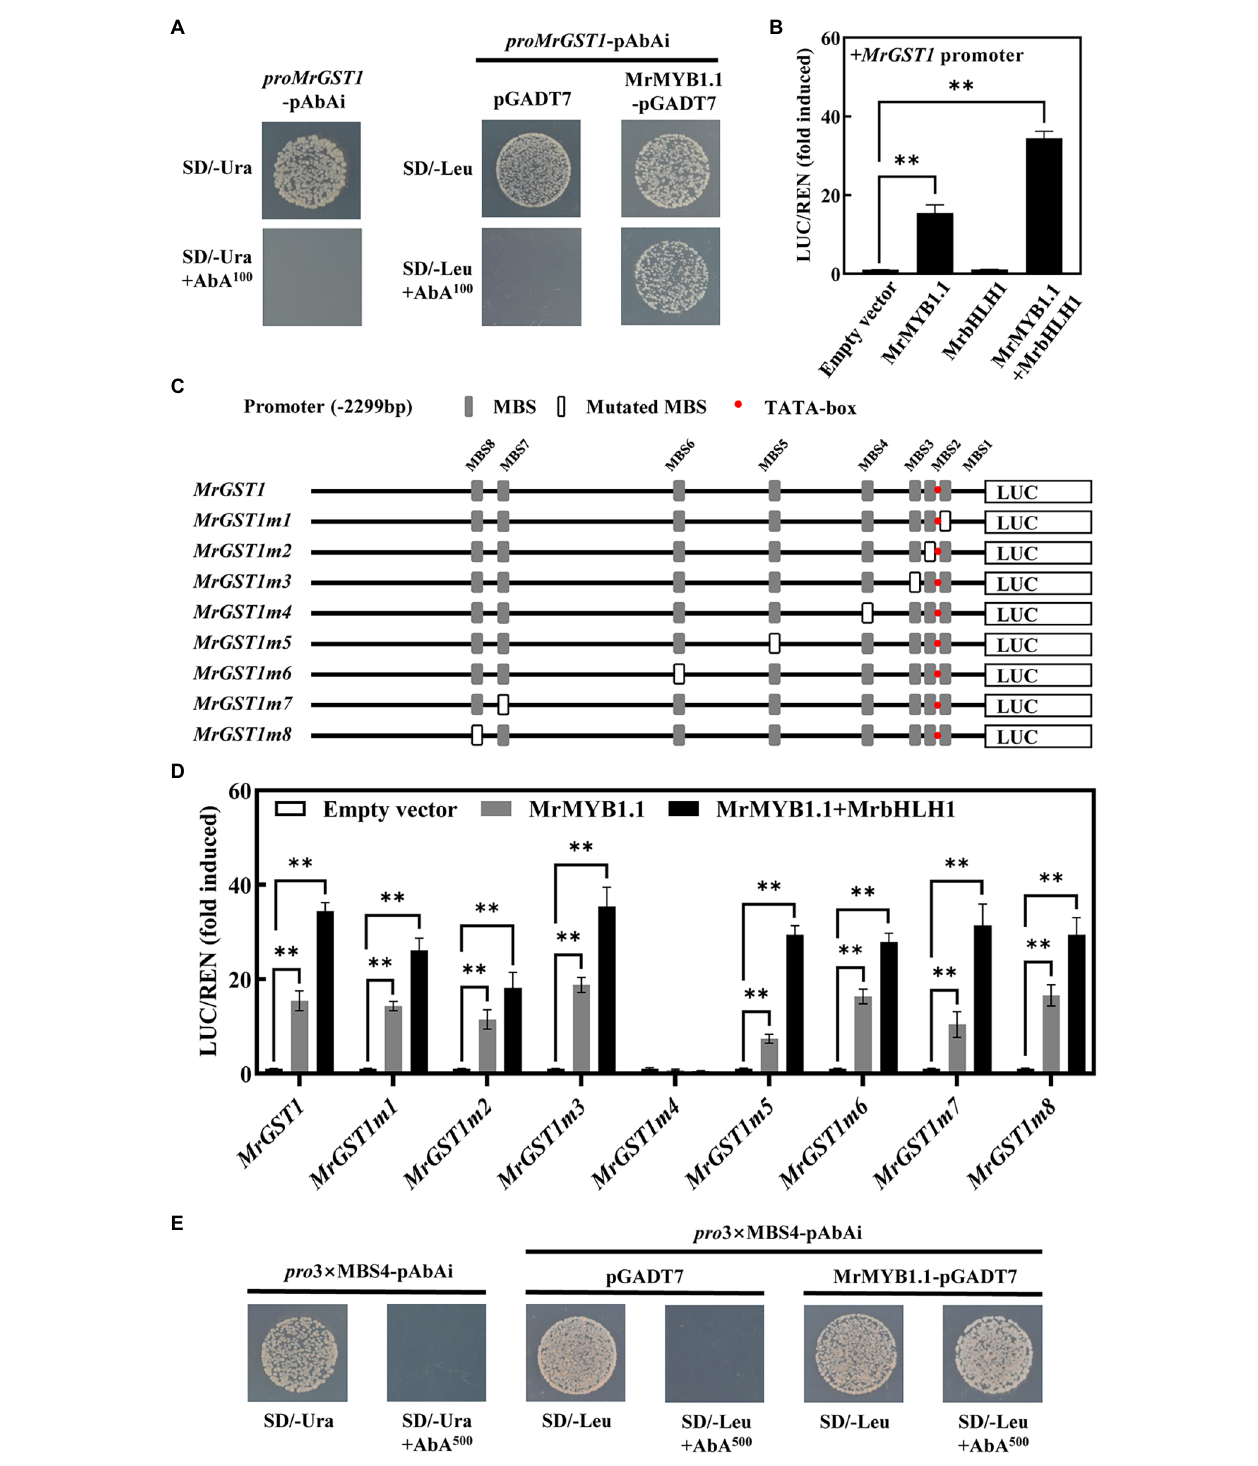
FIGURE 6 | Activation of the MrGST1 by MrMYB1.1. (A) Yeast one-hybrid interaction between MrMYB1.1 and MrGST1 promoter. (B) Effects of MrMYB1.1 (+/ − MrbHLH1) on the promoter activity of MrGST1 measured by dual-luciferase assays. (C) Schematic diagrams of the MrGST1 promoter with eight MYB binding site (MBS) motif mutations. (D) Effects of MrMYB1.1 (+/ − MrbHLH1) on the activity of original and mutated promoters of MrGST1 measured by dual-luciferase assays. (E) Yeast one-hybrid interaction between MrMYB1.1 and three tandem repeats of MBS4 motif of MrGST1 promoter. Data were means (±SE) from three independent biological replicates. Asterisks (**) indicate significant differences at p < 0.05